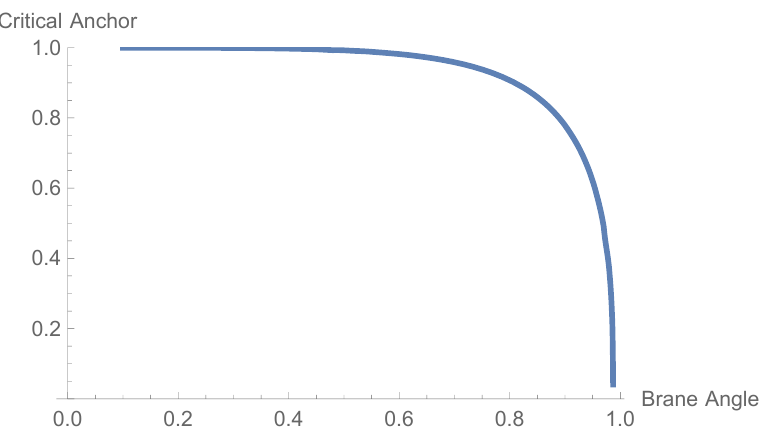
Figure 3: The critical anchor on the brane, given here in four dimensions, is a mono- tonically decreasing function of the brane angle which vanishes at the critical angle, ≈ .98687. The critical anchor tends toward which in this case is approximately θ c = 1) as θ → 0 and tends toward zero as θ → θ the horizon distance ( u h c